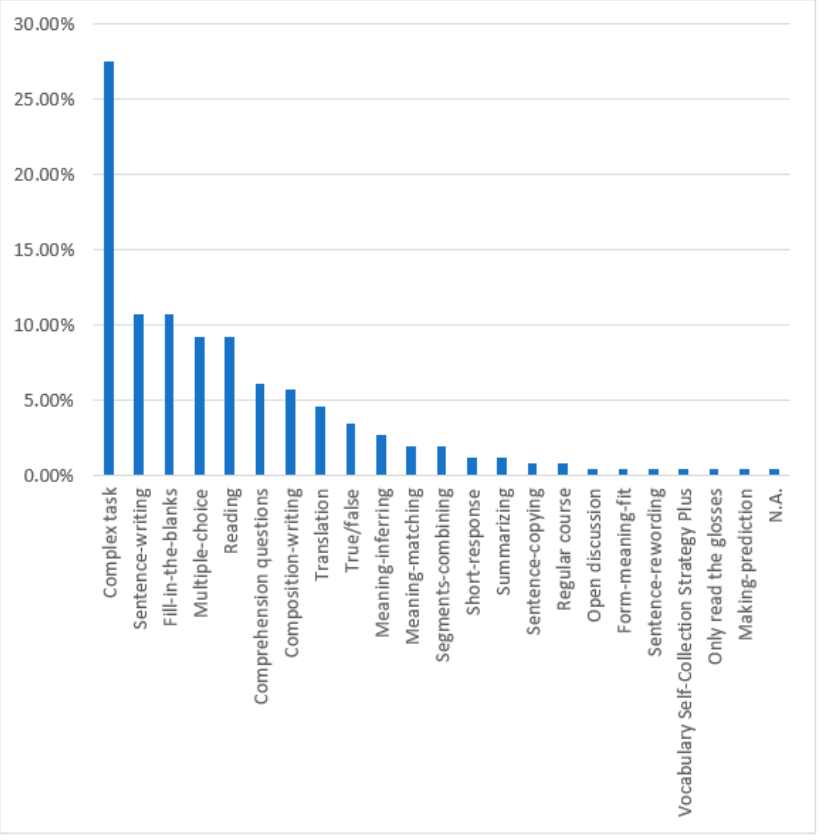
Figure 9. Task types.